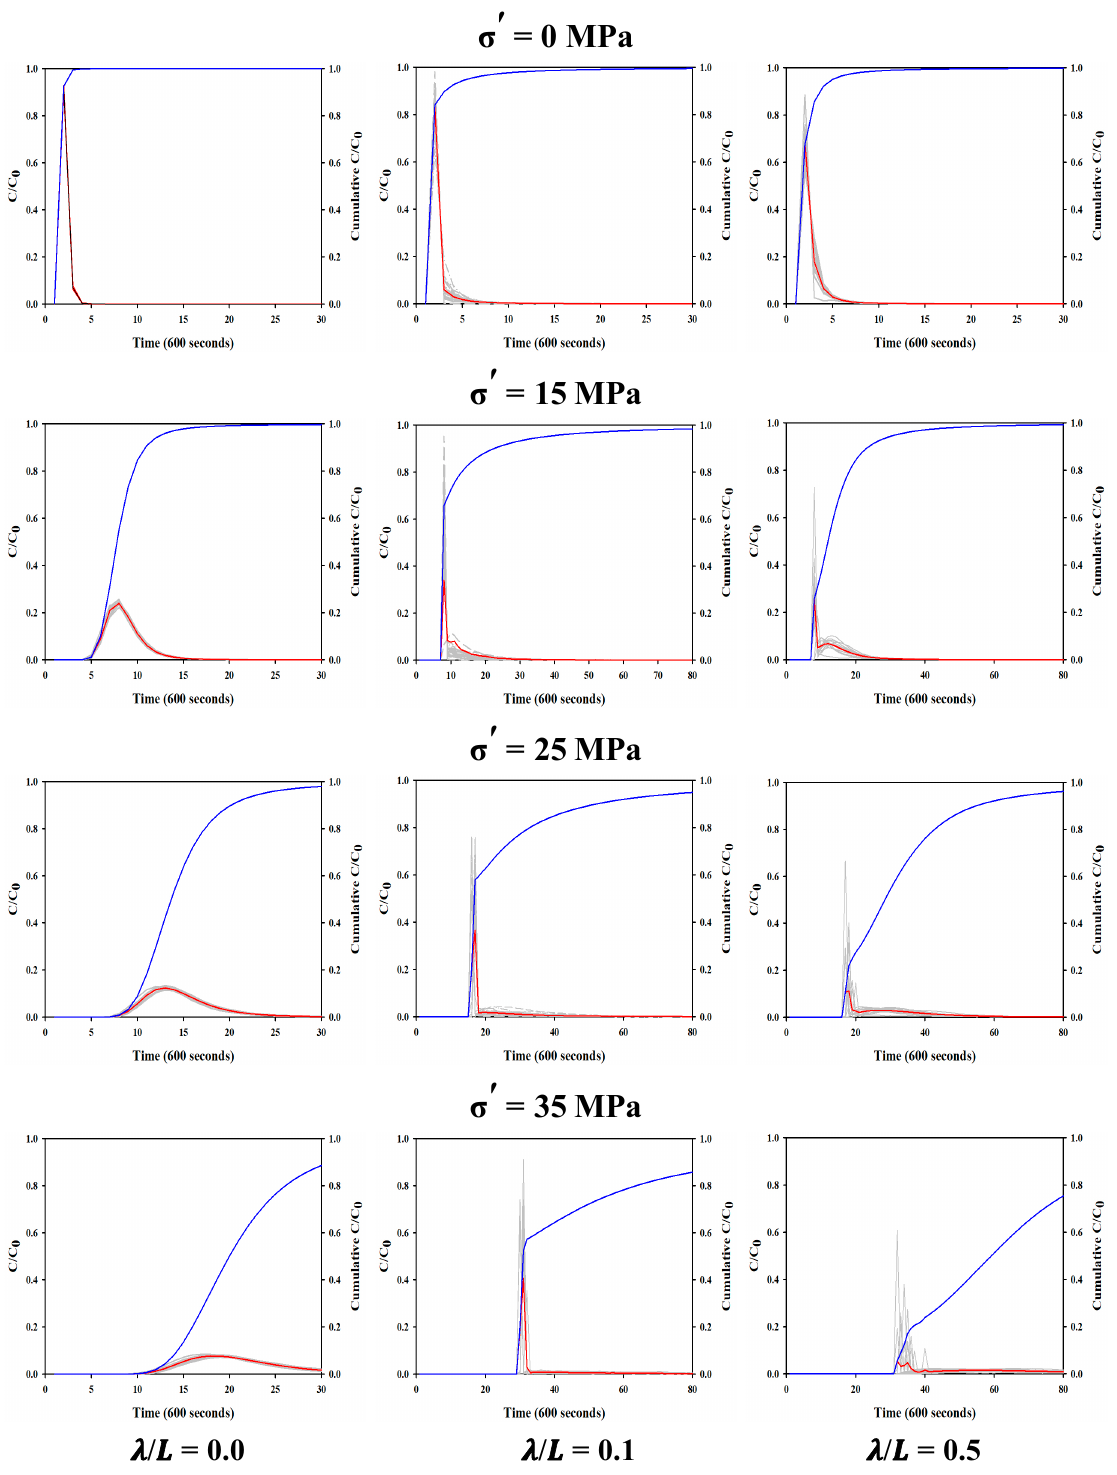
Figure 6. Variations in breakthrough curves of solutes based on λ / L and σ (cid:48) . The red line refers to the average of breakthrough curves (bold gray lines) calculated through 30 random numbers, and the blue line to the accumulated breakthrough curves.